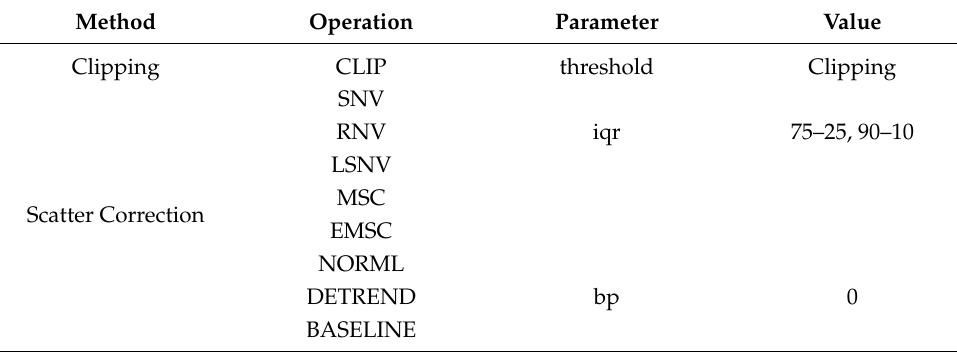
Table 2. Methods, operations, and parameters of spectral